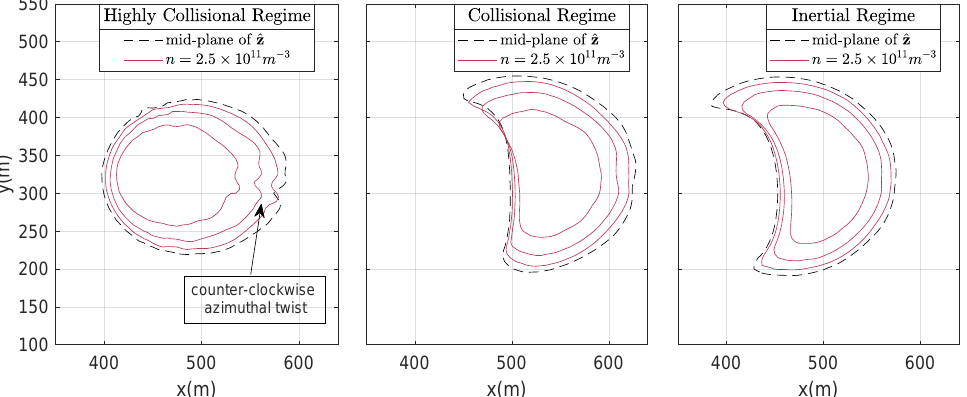
Figure 9. Contour plots of different latitudes above the mid-plane of ˆ z at a single density value, for each of the three regimes: highly collisional (i.e., ν in = 29.6 Hz), collisional (i.e., ν in = 2.96 Hz), and inertial (i.e., ν in = 0.296 Hz).